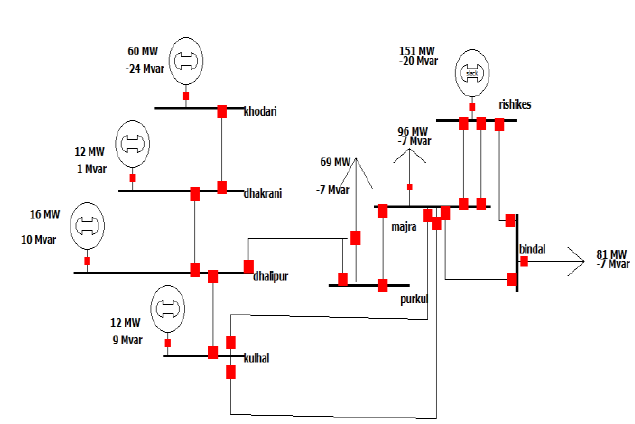
Fig.11 Dehradun area power system on PWS (with 2007-2015 load change)